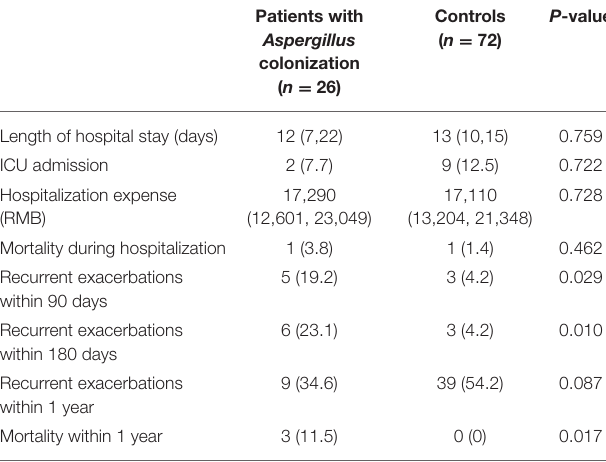
TABLE 4 | Prognosis of hospitalized COPD patients with or without Aspergillus